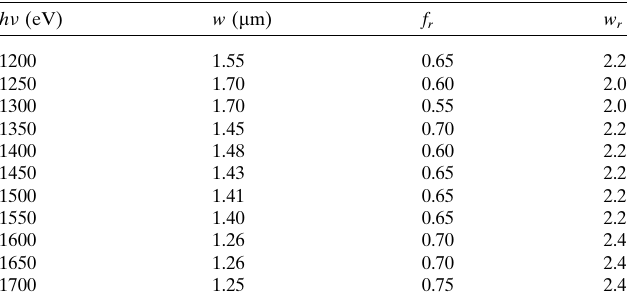
Table 3 Best-fitting parameters modeling the experimental CSDs measured at photon energies between 1200 and 1700 eV with the double Gaussian superposition described in the text. h (cid:3)